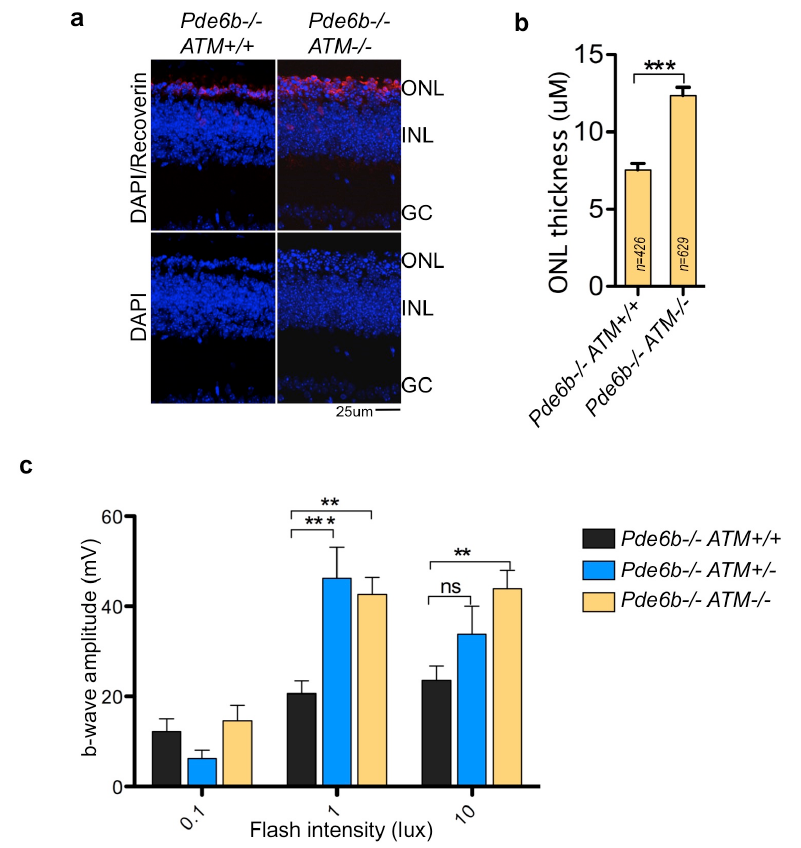
Figure 8. Loss of ATM promotes photoreceptor survival. ATM expression was knockdown in rd1 background and postnatal day 20 mice retina were analyzed by different methods. ( a and b ) Immunofluorescence using the anti-Recoverin antibody performed on retinal sections of Pde6b -/- ATM +/+ and Pde6b -/- ATM -/- mice. Line scan analysis was performed and outer nuclear layer thickness was quantified using Recoverin staining (detailed in Methods). Column bars represent Mean for, “n” number of line scans, performed on n=32 sections from n=2 Pde6b -/- ATM +/+ and n=3 Pde6b -/- ATM -/- animals. ( c ) Electroretinogram of mice retina was performed in dark adapted animals and b-wave was quantified. Column bars represent mean for n=18 electroretinogram (ERG) readings from n=9 animals for each Pde6b -/- ATM +/+ and Pde6b -/- ATM -/- genotype; and n=12 ERG readings for n=6 mice with Pde6b -/- ATM -/+ genotype. Error bars represent SEM. *P ≤ 0.05; **P < 0.01, ***P < 0.001 using Mann-Whitney test ( b ) and one-way-ANOVA followed by Turkey test ( c